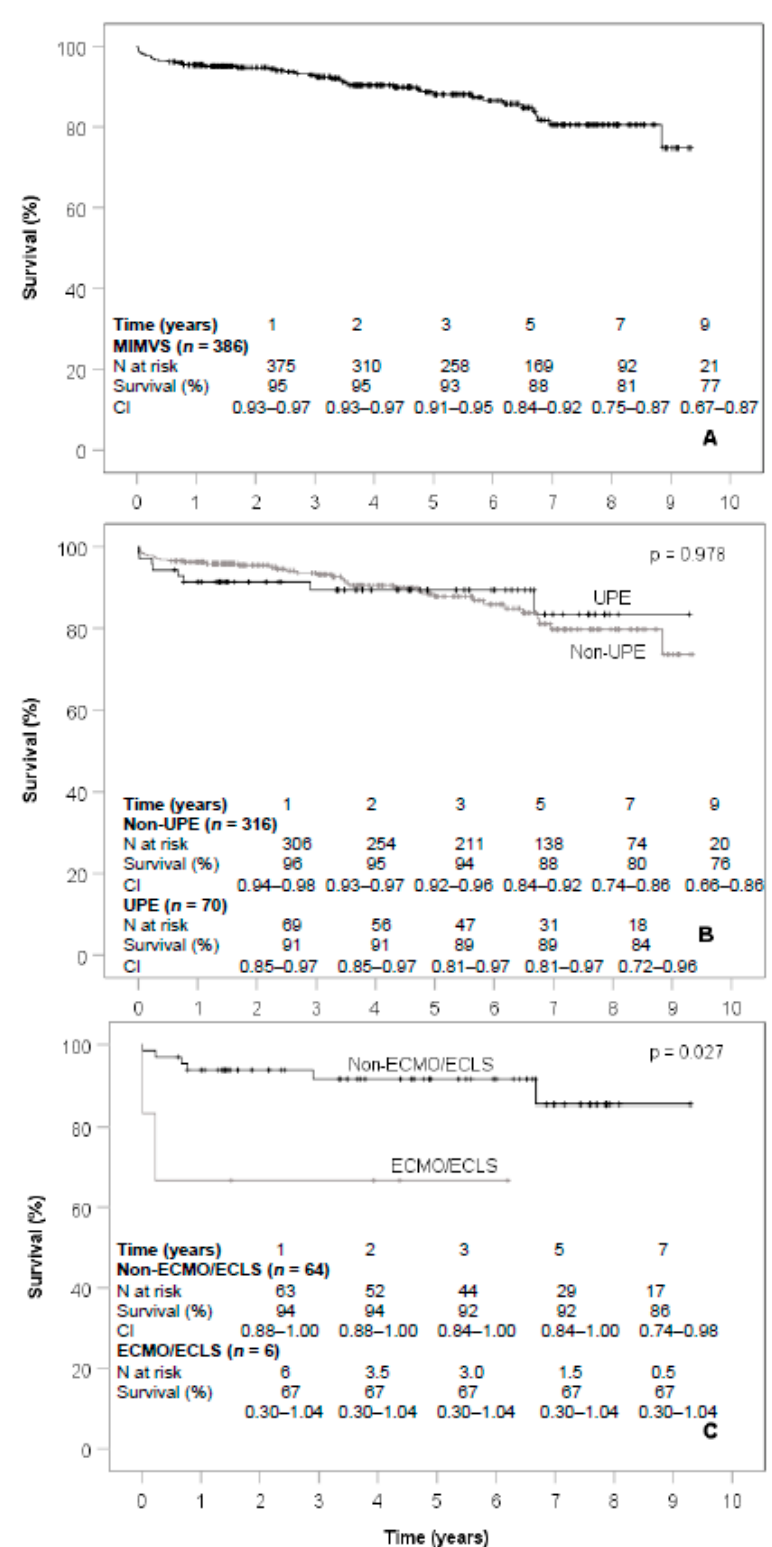
Figure 5. Kaplan-Maier long-term survival curves of the analyzed subgroups. ( A ) Survival curve of the MIMVS patients. ( B ) Survival curves of the UPE group and the non-UPE group. ( C ) Survival curves of patients requiring ECLS vs. non-ECLS within the UPE group. N, number; MIMVS, minimal-invasive mitral valve surgery; CI, confidence interval; UPE, unilateral pulmonary edema; ECLS, extracorporeal life support; ECMO extracorporeal membrane oxygenation.